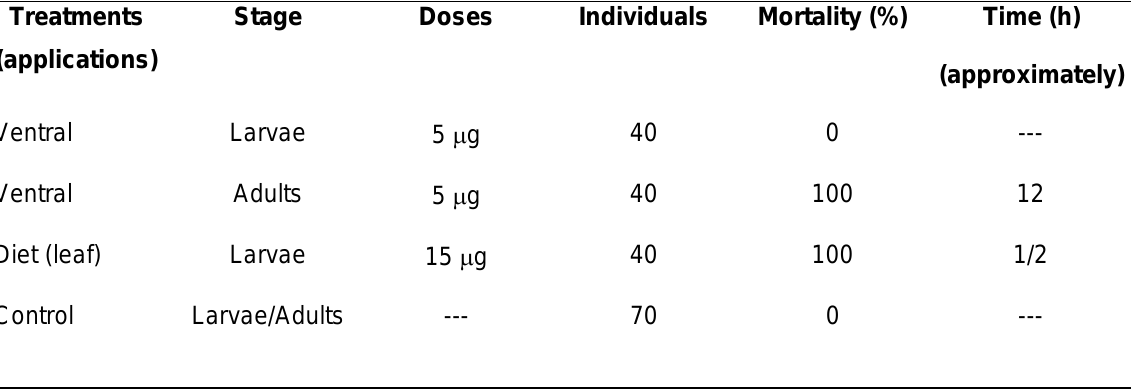
Table 1. Bioassay with Spodoptera frugiperda using the affinity purified MBP-GlyTX4 recombinant protein cleaved with the Xa